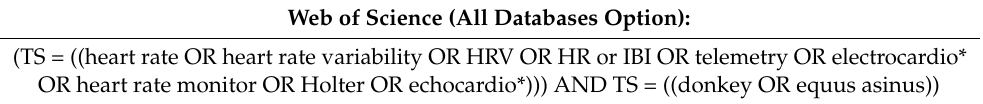
Table 1. Search query formulated for Web of Science